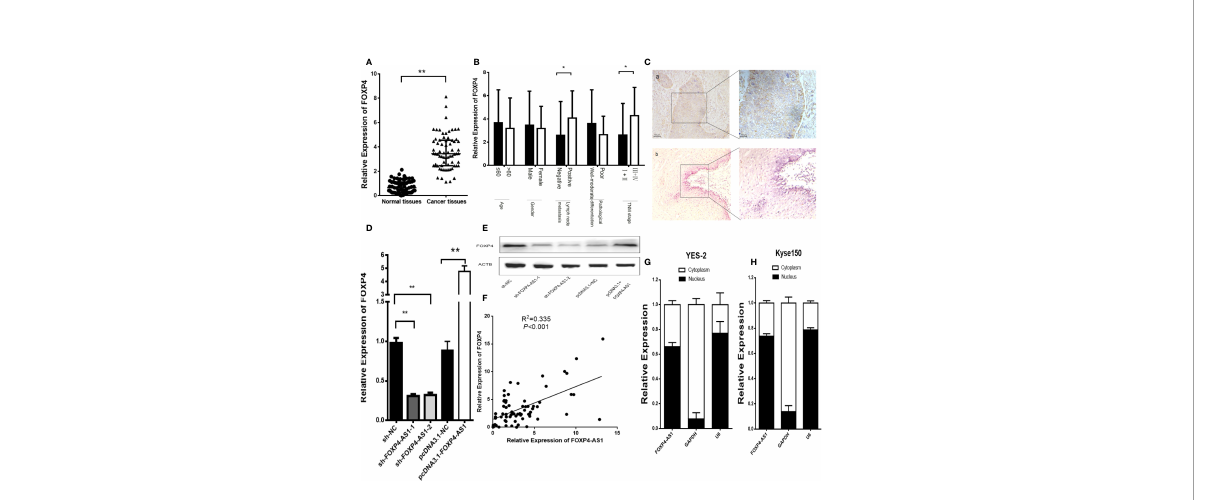
FIGURE 3 FOXP4 is highly expressed in ESCC and increased by FOXP4-AS1 at the mRNA and protein levels. The expression of FOXP4 in ESCC tissues (A) and different subgroups (B) by qRT – PCR. (C) FOXP4 protein in ESCC by IHC (SP Left×200; Right×400). a: ESCC tissue; b normal tissue. FOXP4 mRNA (D) and protein (E) levels with FOXP4-AS1 by qRT – PCR or WB. (F) The correlation between FOXP4-AS1 and FOXP4 by qRT – PCR. Subcellular localization of FOXP4-AS1 in YES-2 (G) and Kyse150 (H) , GAPDH and U6 were used as cytoplasmic and nuclear controls. * p < .05 and ** p < .01.